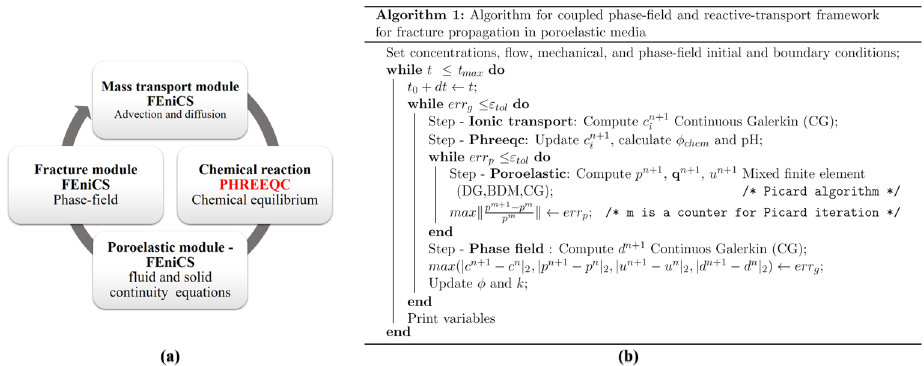
Figure 2. ( a ) Flowchart of the framework, where each time step starts by solving the mass transport module, followed by geochemical calculations in PHREEQC. The updated geochemical variables are then used to calculate fluid pressure, displacement, and velocity fields. Finally, the fracture phase-field variable is solved at the end of each time step to update the porosity and permeability subsequently. ( b ) Algorithm of the coupled phase- field and reactive-transport framework for fracture propagation in poroelastic